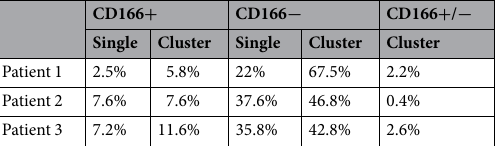
Table 1. Percentage distribution of single and clustered cartilage stem cells (CD166 + ), single and clustered chondrocytes (CD166 − ), and combined clusters of stem cells and chondrocytes (CD166 + / − ) in osteoarthritis patient cartilage from femoral condyle. Clusters were defined as multiple cells occupying or appearing to occupy a single chondron. For each patient sample, cells in 4 independent fields of view (at 10X magnification) were individually counted to evaluate cell